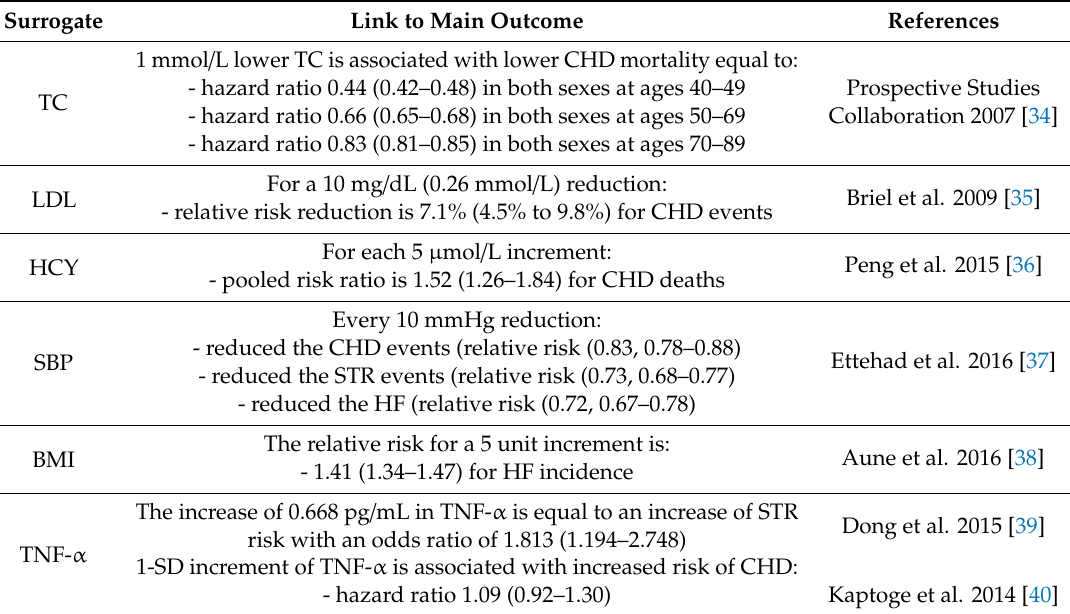
Table 2. Articles used to estimate the e ff ect size of a single concentrate product on a specific clinical